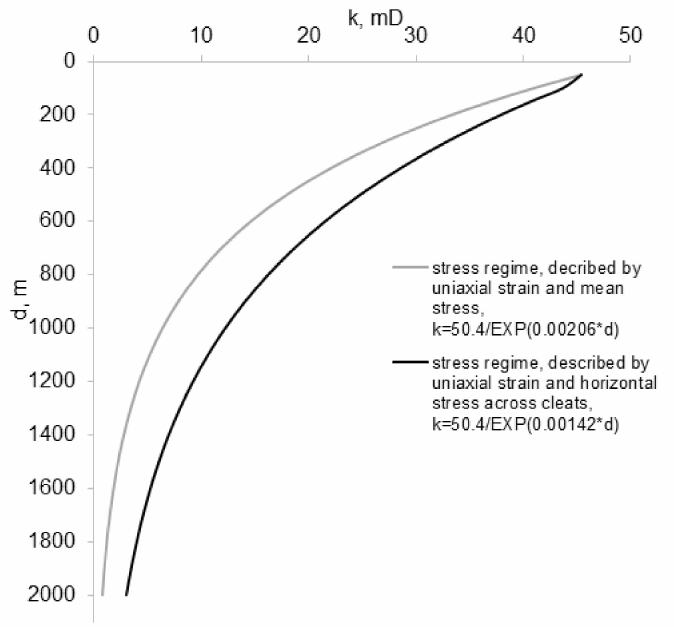
Figure 11. Permeability of the coking coals perpendicular to the face cleat direction: permeability depth dependence for stress regimes, described by uniaxial strain and mean stress (gray line) and horizontal stress across cleats (black line). Table 4. The predicted coking coal permeabilities for stress regime, described by uniaxial strain and mean